Question: What visual encoding does this figure use to show its data?
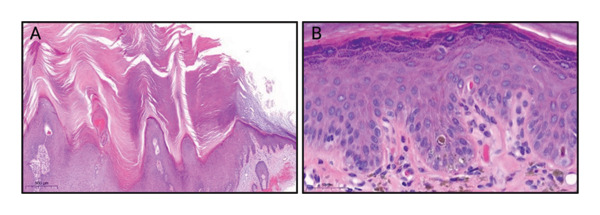
Answer: scatter